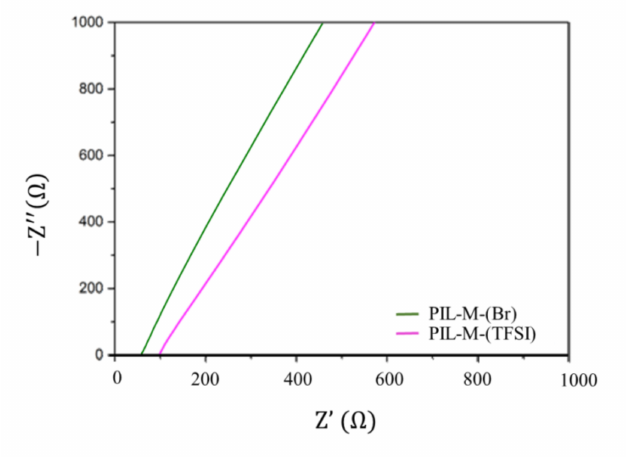
Figure 4. Alternating current (AC) impedance of PIL-IL